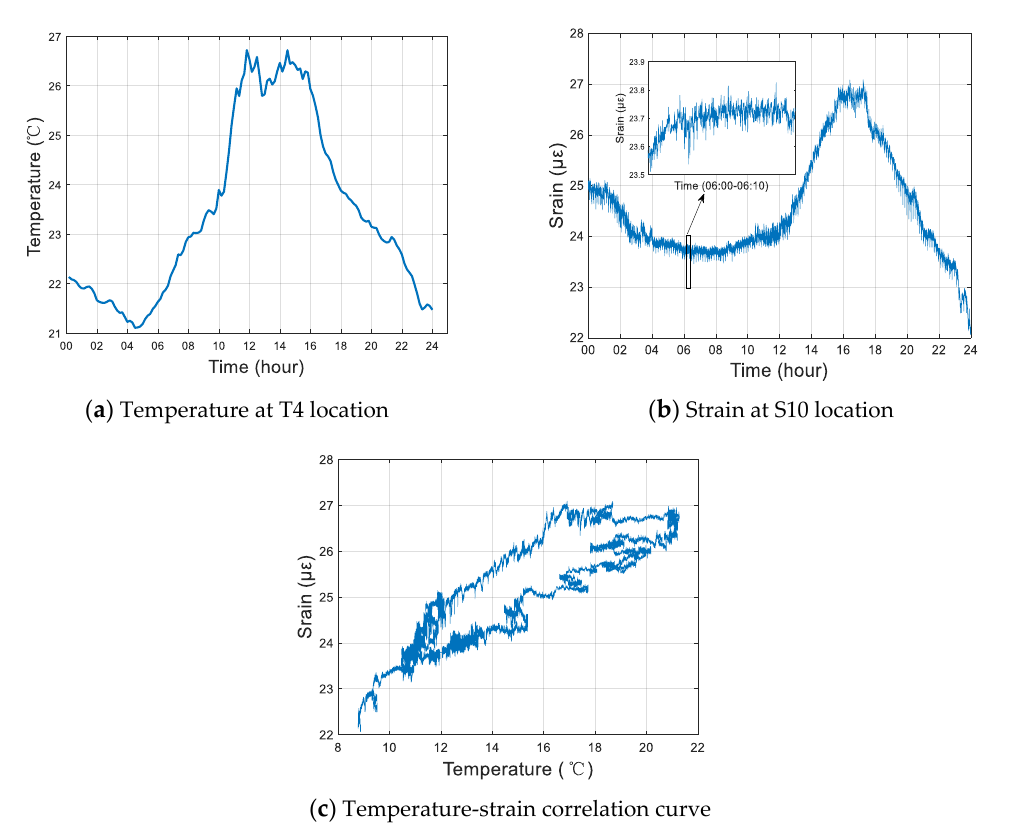
Figure 2. Time history plots of ( a ) temperature, ( b ) strain, and ( c ) temperature-strain correlation curve on 4 April 2017. on 4 April